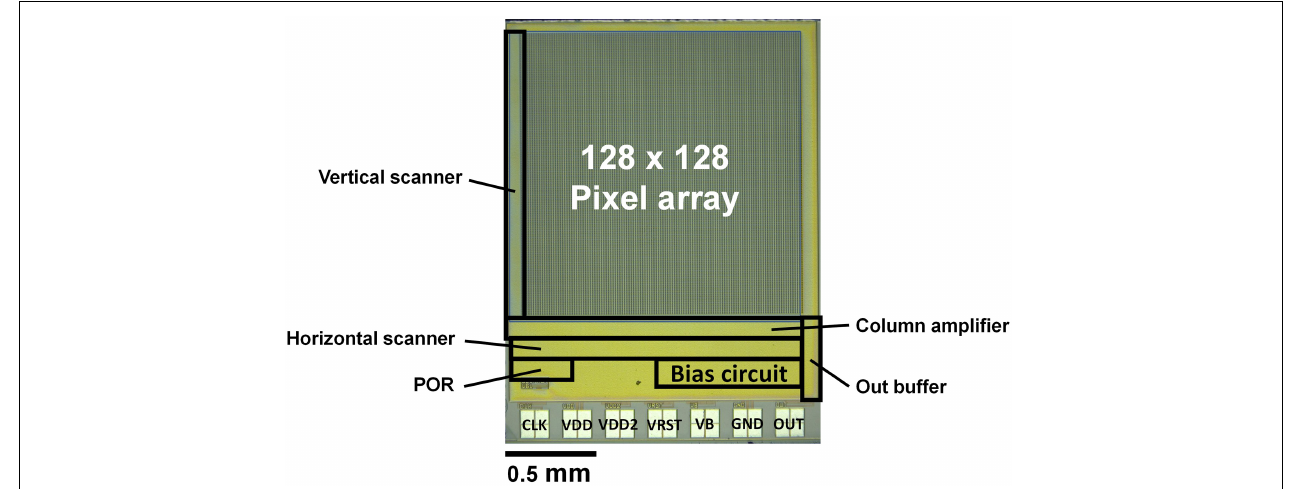
FIGURE 5 | Graphic of the proposed image sensor.